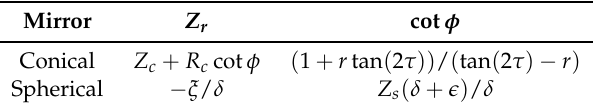
Table 5. Definition of cot φ and Z r for different